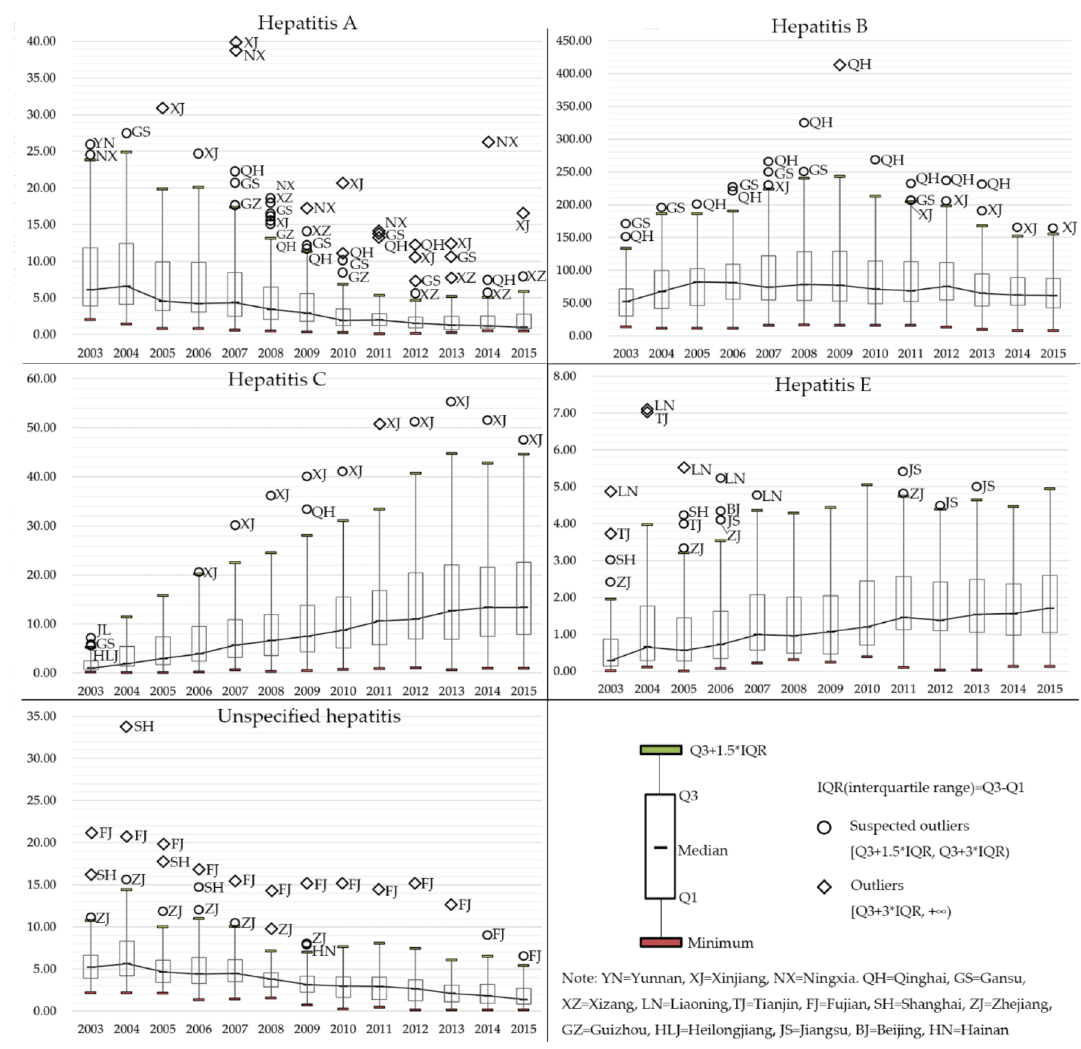
Figure 2. Box plots of the incidence of different types of viral hepatitis from 2003 to